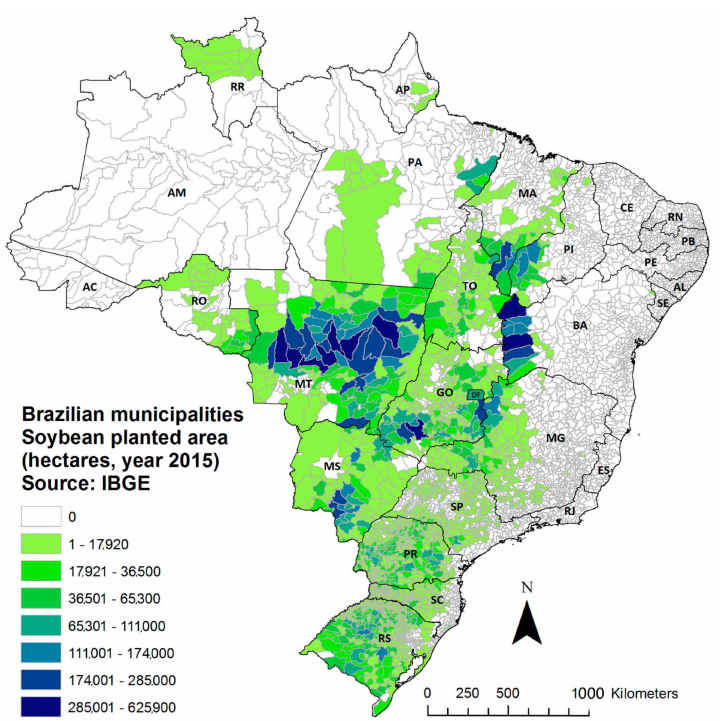
Figure 2. Brazilian municipalities and soybean planted area in 2015. Letters indicate abbreviations of Brazilian